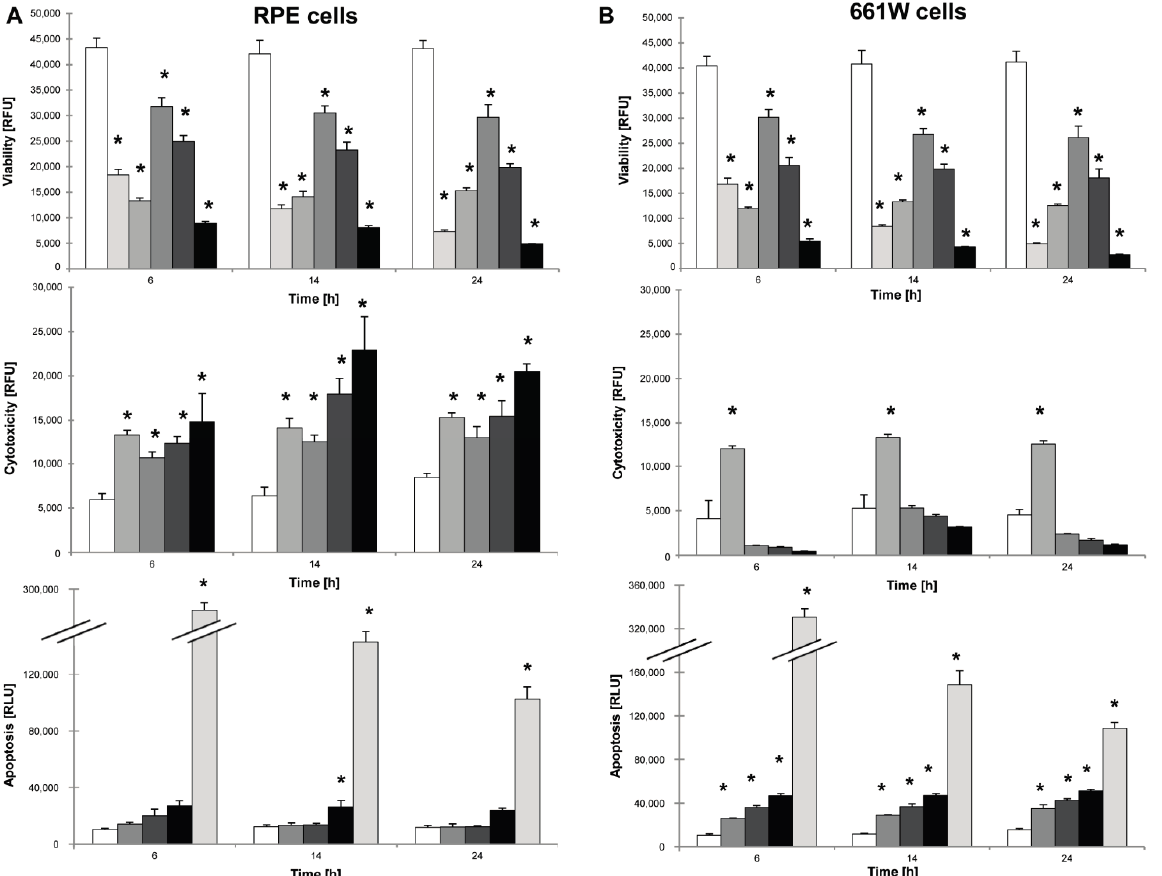
Figure 5. NaIO 3 is cytotoxic for RPE cells, but induces apoptosis in PRC in vitro . ( A ) NaIO